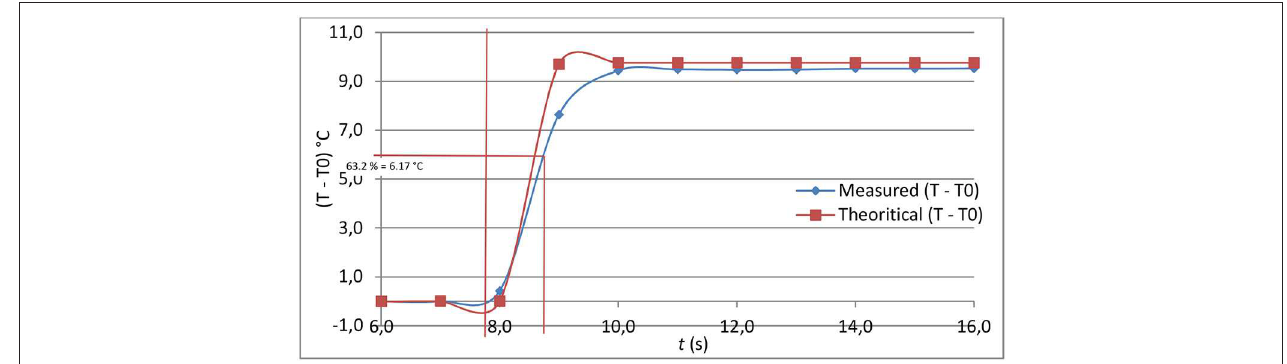
FIGURE 5 | Determination of the response time of MoSens module n ◦